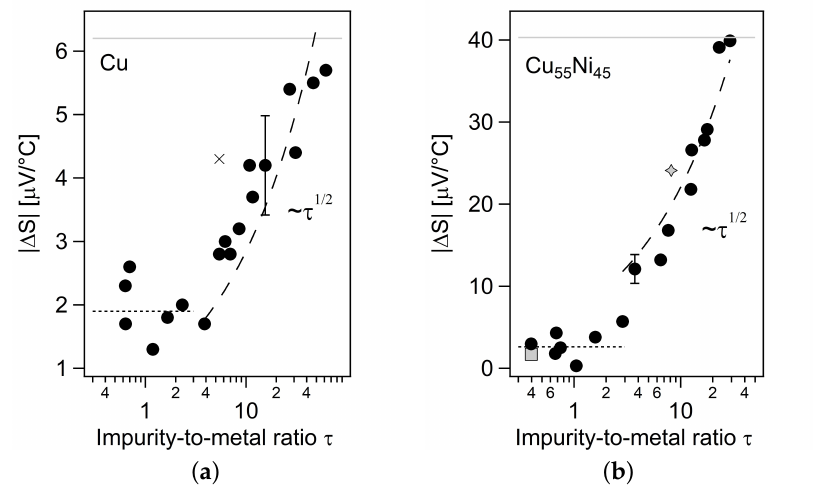
Figure 2. The deviation of the thin film Seebeck coefficient from the bulk value plotted as function of the impurity-to-metal impingement flux ratio for ( a ) copper and ( b ) constantan. The depositions are performed at a discharge current of 0.6 A, an argon pressure of 0.6 Pa and a target-to-substrate distance of 10 cm. The impurity-to-metal ratio was increased by leaking atmospheric impurities inside the vacuum chamber. The full gray lines in the figures indicate the maximal deviation | ∆ S | max for copper (6.2 µ V/ ◦ C) and constantan (40.1 µ V/ ◦ C). The dotted lines represent the average deviation from the bulk value in the low-impurity regime for copper (1.9 µ V/ ◦ C) and constantan (2.61 µ V/ ◦ C) and the striped lines represent the power law | ∆ S | ∼ τ 1/2 . Error bars are included on a single marker but are valid for all data points in the respective plots. The data point represented by the cross marker ( a ) was excluded from the fit for the proportionality factor. The gray square and diamond markers ( b ) represent data points from the experiment discussed in Section